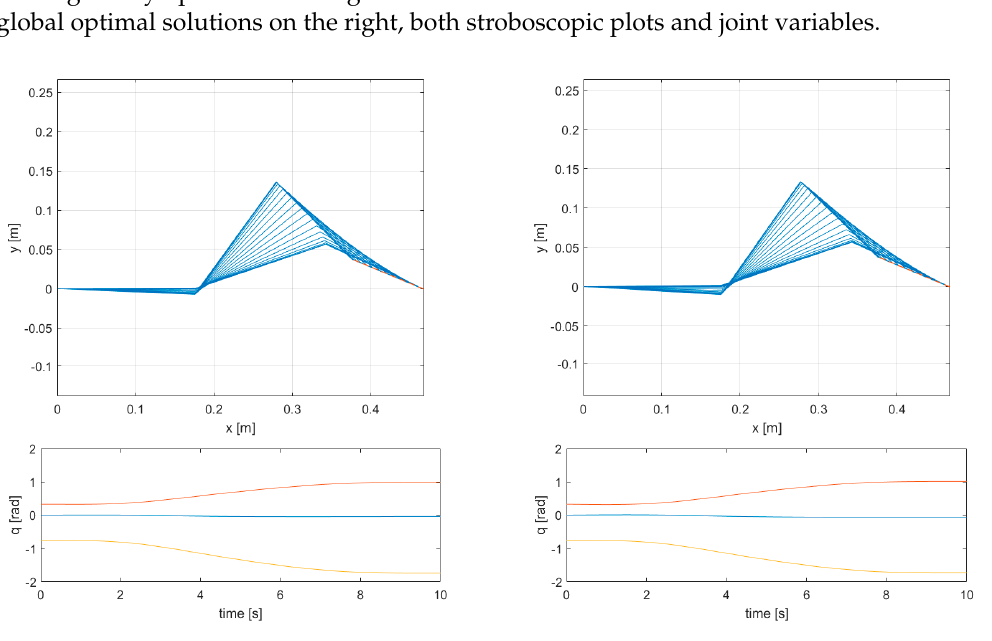
Figure 9. Trajectory 1, comparison between PMKE ( left ) and global optimal solution ( right ). First joint: blue lines; second joint: red lines; third joint: yellow lines.